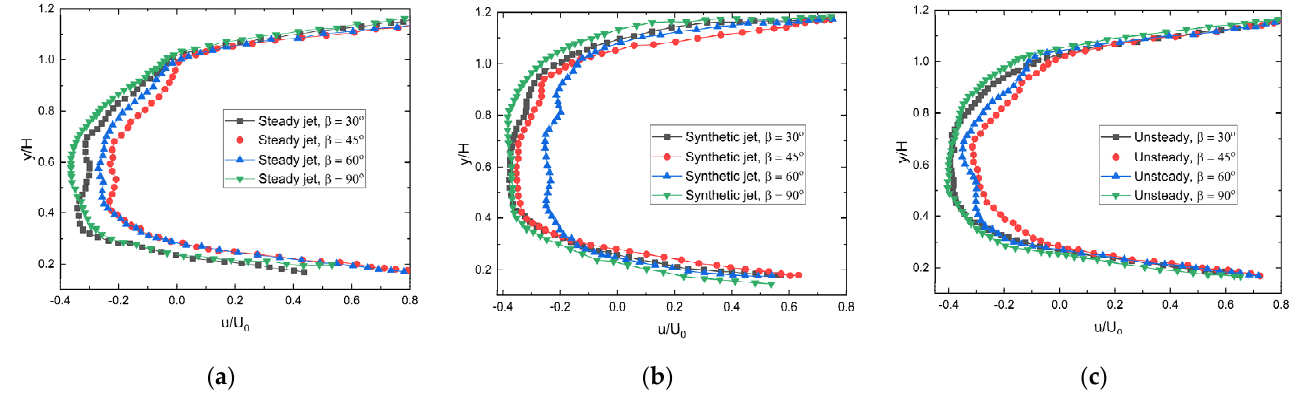
Figure 20. Vertical normalized streamwise velocity profiles measured at x/H = 0.5 in the symmetry plane with different actuator types at various jet angles. ( a ) A steady blowing jet; ( b ) a synthetic jet; ( c ) an unsteady jet.